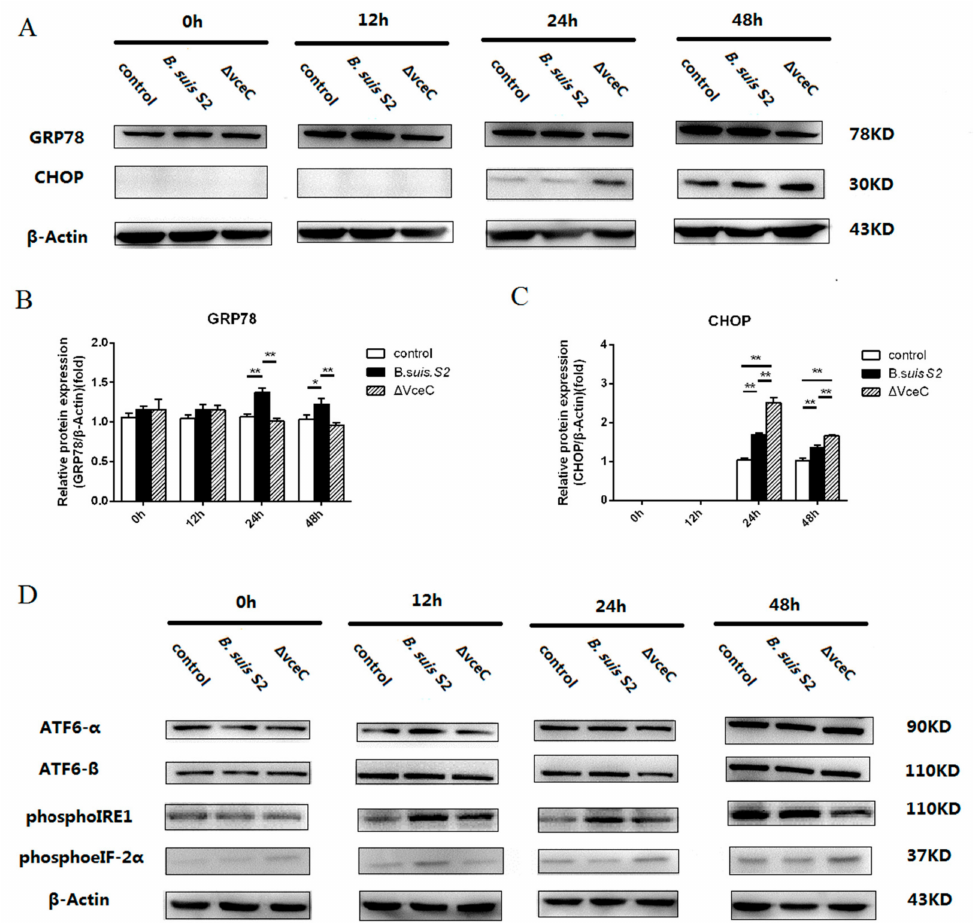
Figure 4. The unfolded protein response (UPR) pathway is induced by B. suis S2 and ∆ VceC. ( A ) GTCs were infected with 100 MOI of B. suis S2 and ∆ VceC for 0 h, 12 h, 24 h, and 48 h, and the untreated group was used as a negative control, followed by lysis and detection of GRP78 and CHOP protein expression by Western blot. The data shown are representative of three independent experiments. ( B , C ) Quantification of band intensities from three independent results was determined by densitometric analysis. Data represent the mean ± standard deviation from three independent experiments at each time point.* p < 0.05; ** p < 0.01 ( D ) GTCs were infected with 100 MOI of B. suis S2 and ∆ VceC for 0, 12, 24, and 48 h, and the untreated group was used as a negative control, followed by lysis and detection of ATF6- α , ATF6- β , phosphoIRE1, and phosphoeIF-2 α protein expression by Western blot. The data shown are representative of three independent